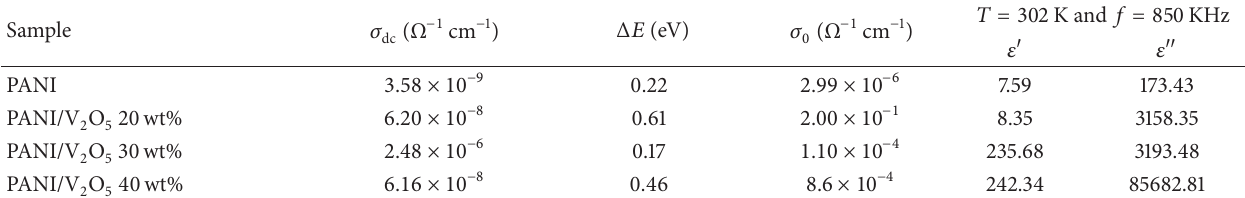
O composite (different weight 2 5